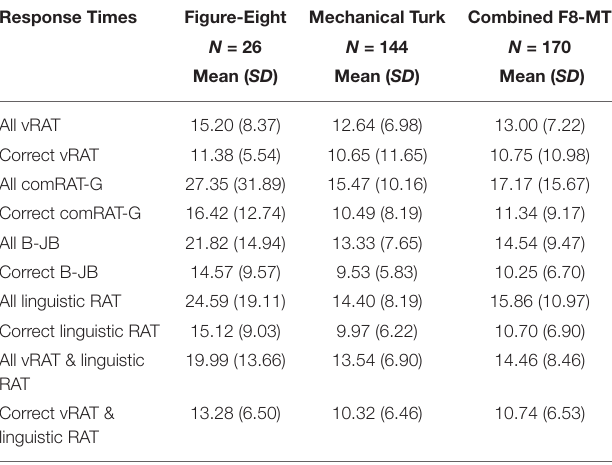
TABLE 3 | Means and Standard Deviations of response times for the visual and linguistic Remote Associates Tests – Study-2. Response Times Figure-Eight Mechanical Turk Combined